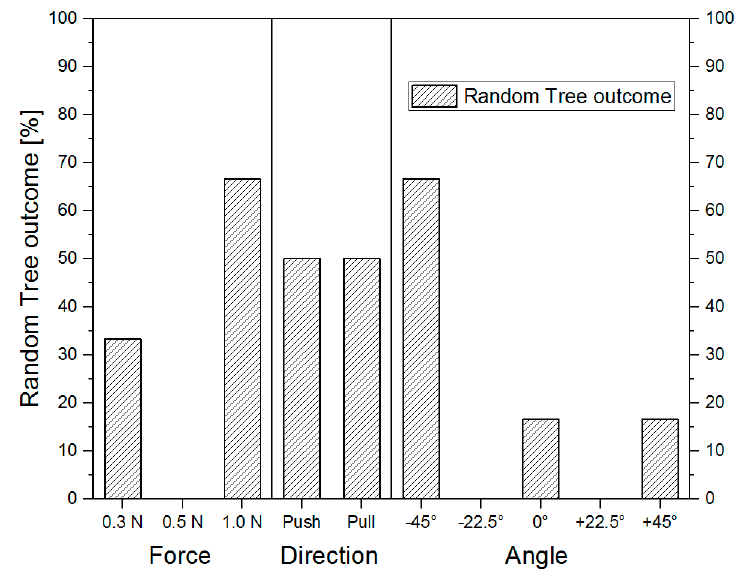
Figure 6. With all decision trees simulated, the resulting outcomes can be evaluated. For the best scratching results via scratch device, the scratching direction can be neglected whereas high scratching forces (1.0 N) and a specific angle ( − 45°) are favored.